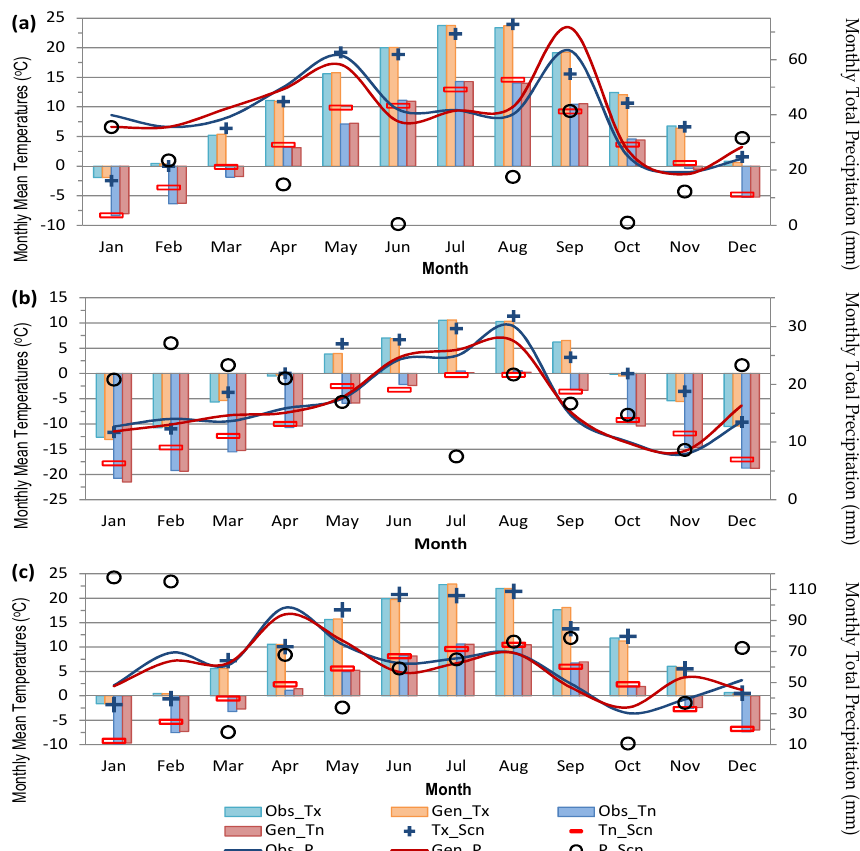
Figure 7. Observed (Obs), generated by LARS-WG weather generator (Gen) for period 1995–2012 and perturbed for short term hypothetical climate change scenario (Scn) for period 2013–2030 for maximum (Tx), minimum (Tn) temperatures ( ◦ C) and precipitation (P in mm), ( a ) Hushe; ( b ) Khunjrab; ( c ) Naltar.